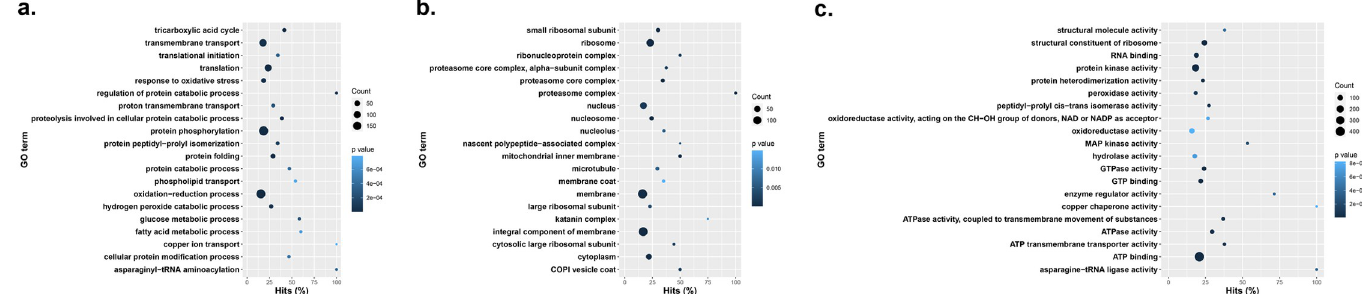
Fig 4. Gene ontology enrichment terms and their prevalence among GR A . palmeri eccDNA samples. A. Biological processes, B. cellular components, C. molecular functions.